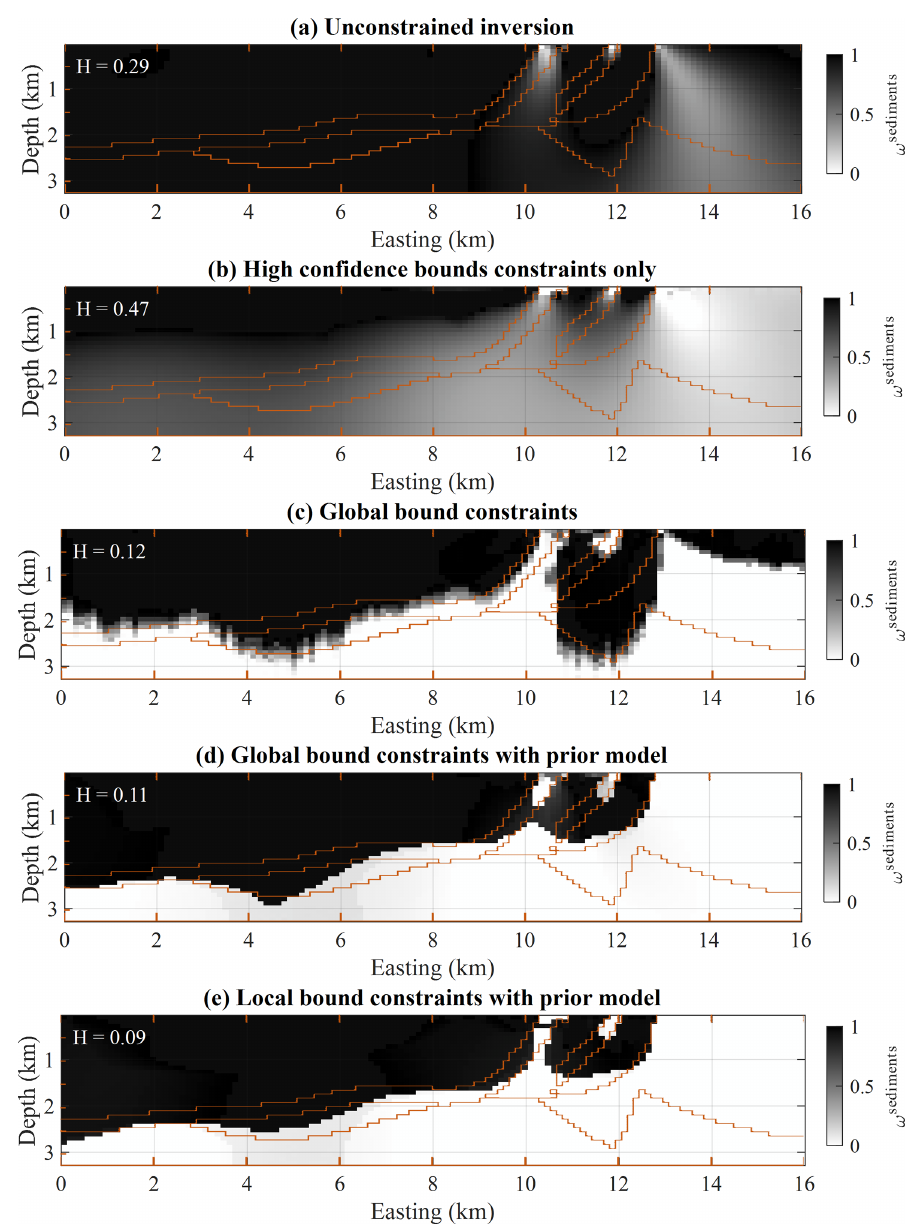
Figure 7. Membership values for the non-magnetic lithologies. Cases (a) through (e) correspond to inversions using prior information and constraints summarised in Table 2. The brown lines materialise the interfaces between geological units in the true model. H refers to the information entropy of the model (Eq.